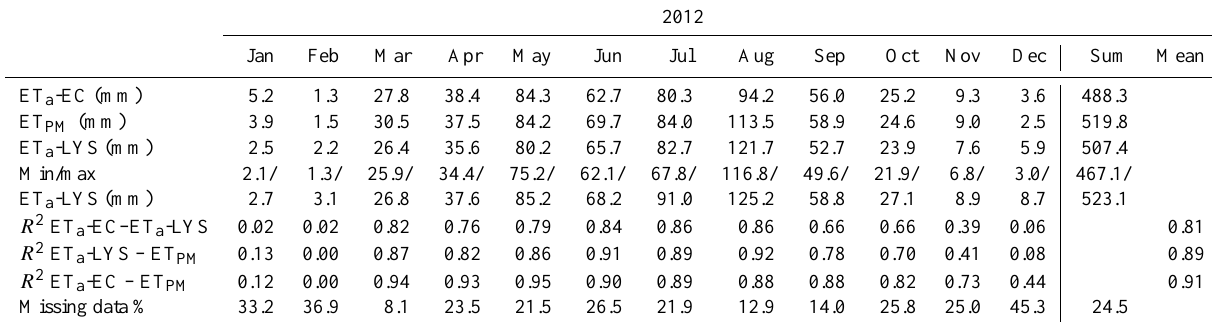
Table 3. Monthly ET a (by lysimeter and EC), ET PM sums, and R 2 between different ET data products on an hourly basis for 2012. “Missing data %” refers to the percentage of hourly ET data (ET a -EC, ET a -LYS) between sunrise and sunset not available for comparison. Hence, the total yearly ET amount is reduced by ca. 18% compared to gap-free ET estimations.